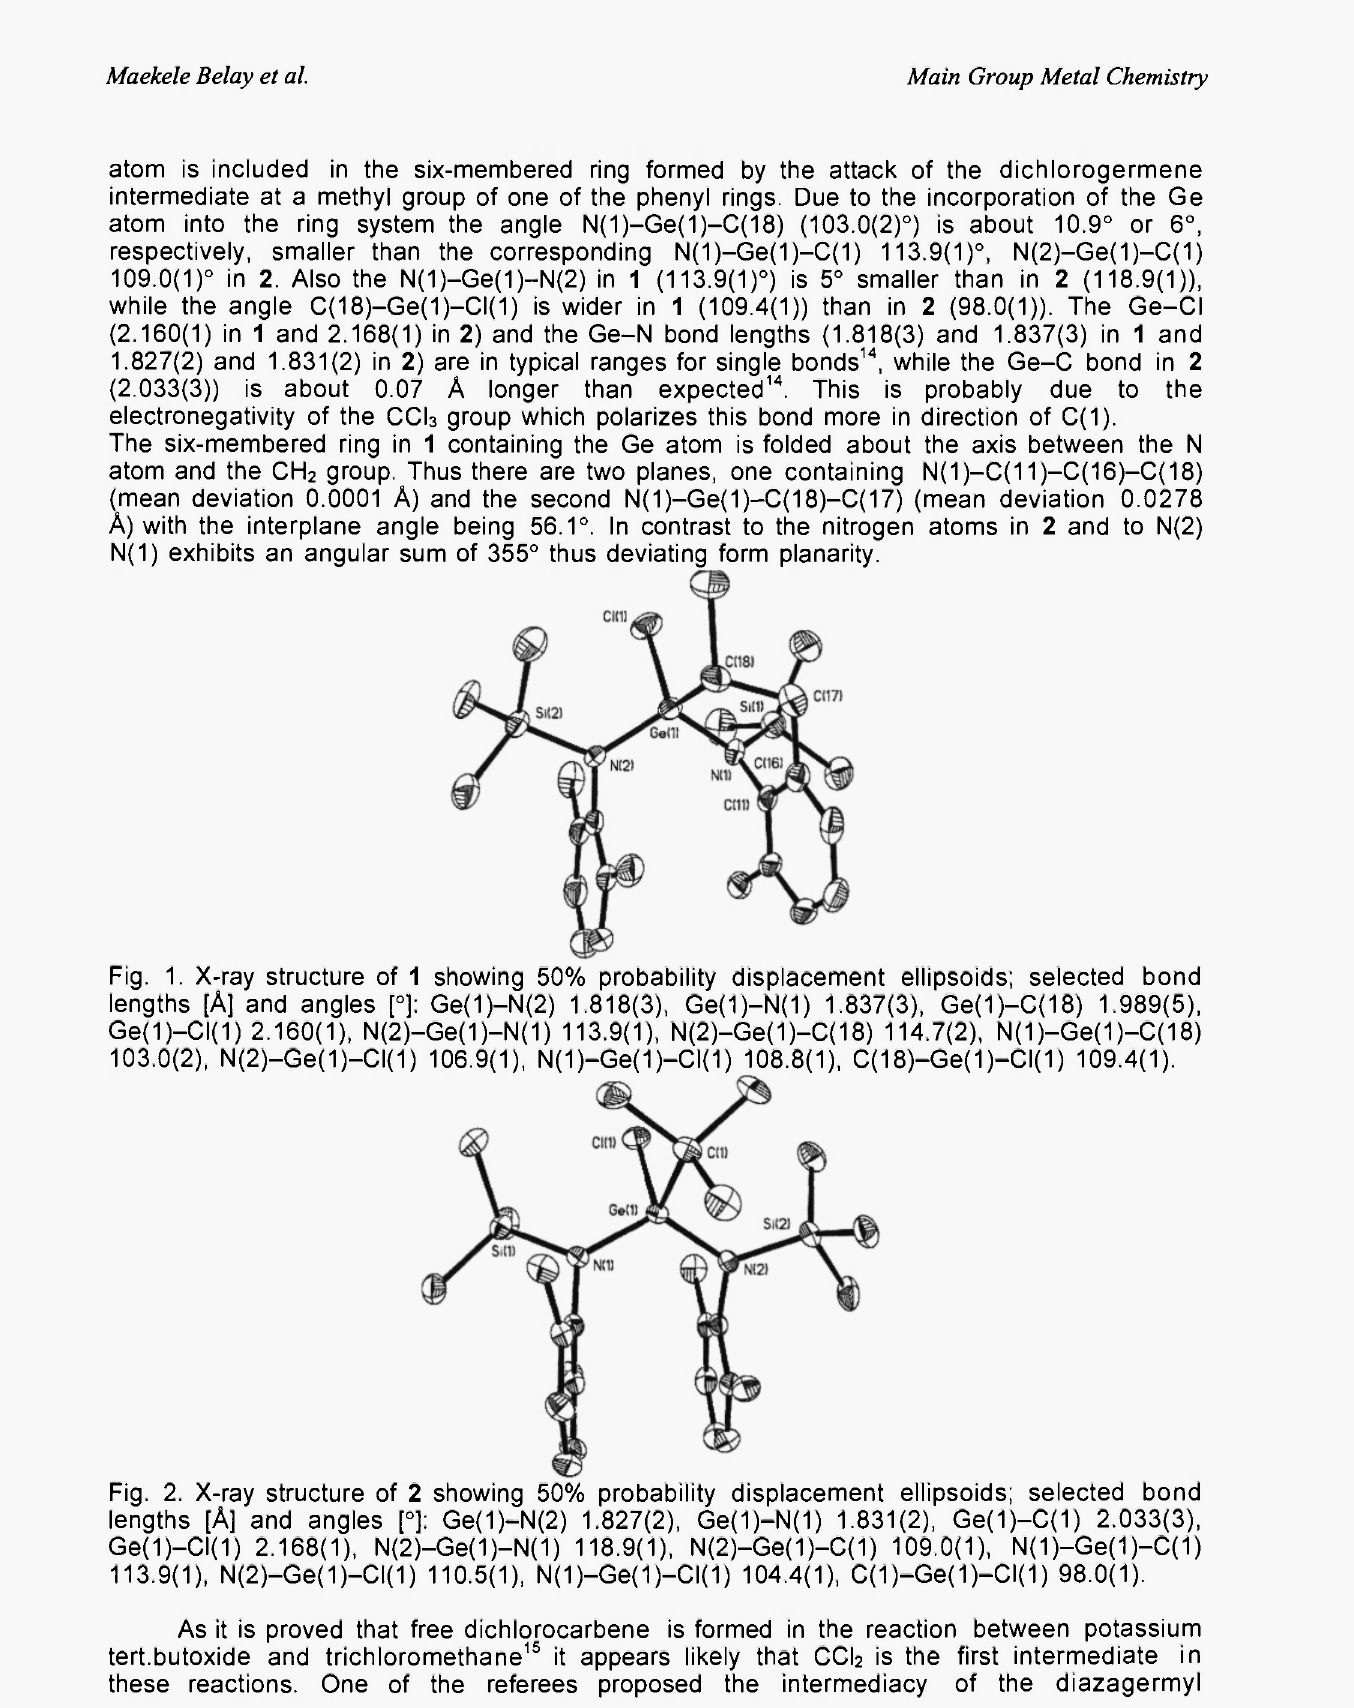
Fig. 2. X-ray structure of 2 showing 50% probability displacement ellipsoids; selected bond lengths [ A] and angles [°]: Ge(1)-N(2) 1.827(2), Ge(1)-N(1) 1.831(2), Ge(1)-C(1)